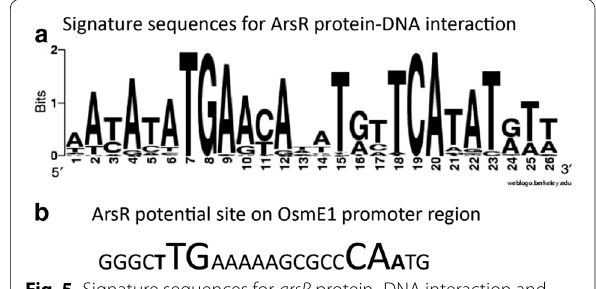
Fig. 5 Signature sequences for arsR protein–DNA interaction and OsmE1 promoter region